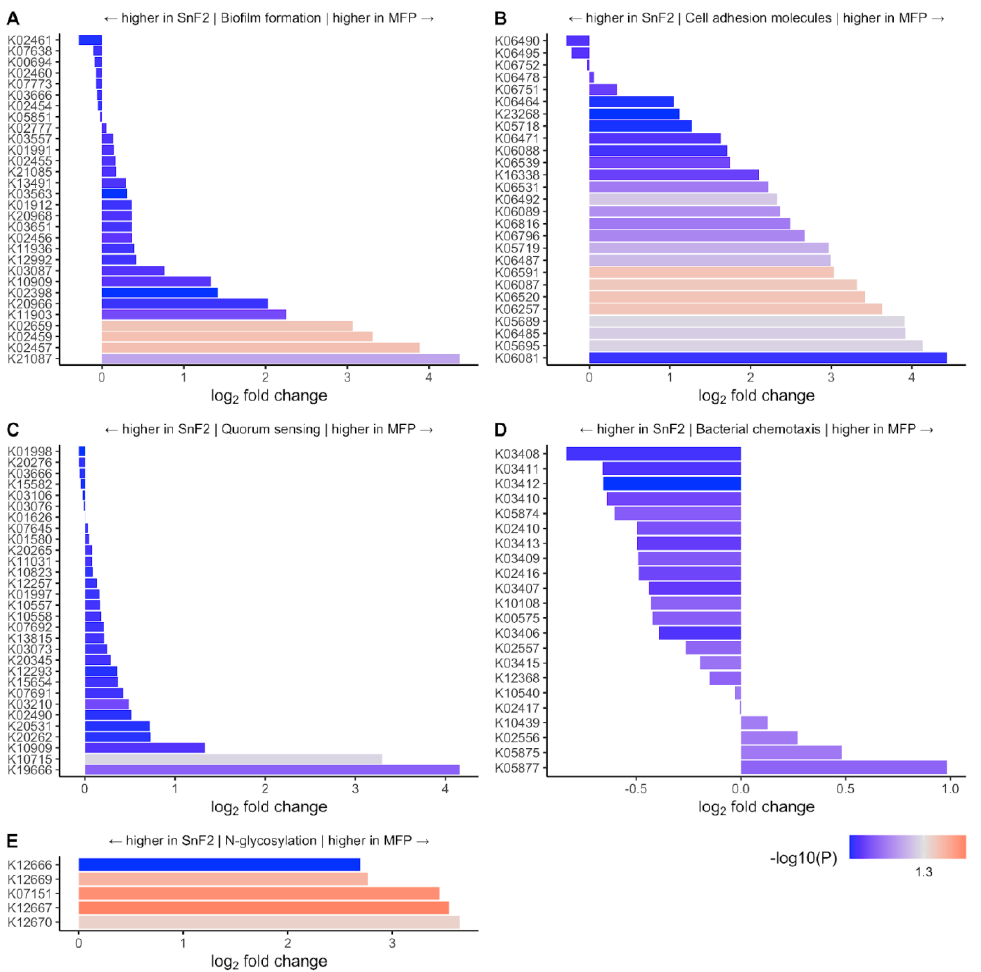
Figure 9. KEGG pathway analysis for the identification of differentially expressed KEGG orthologs. Plots are up to the 30 most significant KOs in each pathway ( A ) Biofilm formation including KEGG pathways map02025, map02026, and map05111; ( B ) Cell adhesion molecules pathway map04514; ( C ) Quorum sensing pathway map02024; ( D ) Bacterial chemotaxis pathway map02030; and ( E ) N-glycosylation by oligosaccharyltransferase module M00072.